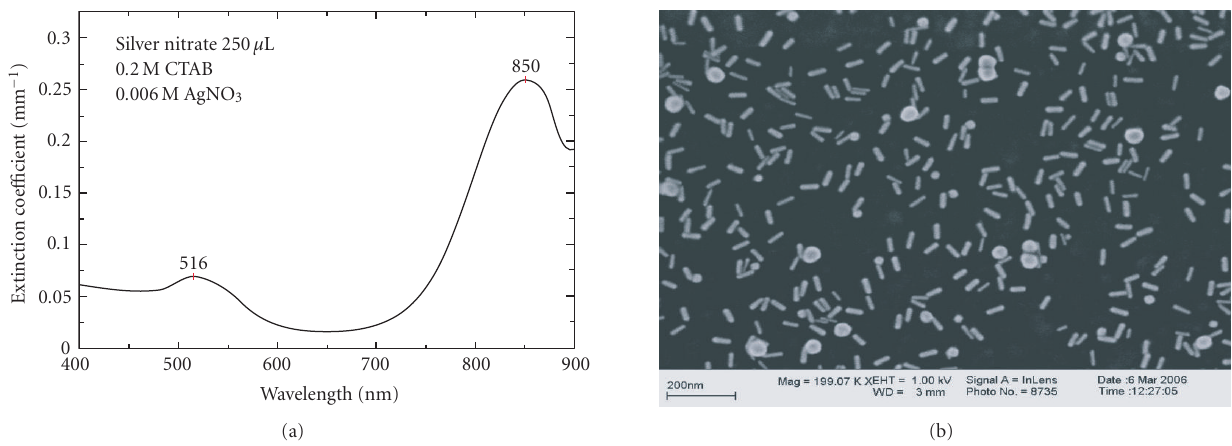
Figure 3: Gold nanorods synthesized using 250 μ L of silver nitrate in growth solution. (a) Optical extinction spectrum showing the transverse plasmon peak at 516nm and the longitudinal plasmon peak at 850 nm. (b) High-resolution scanning electron microscope (SEM)